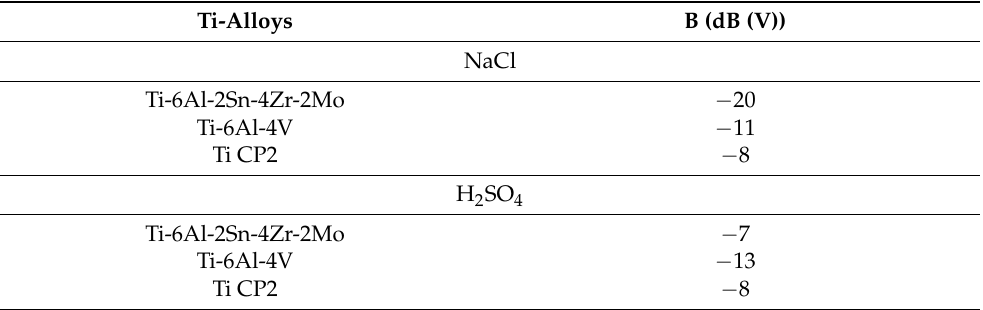
Table 4. Parameters obtained by PSD.